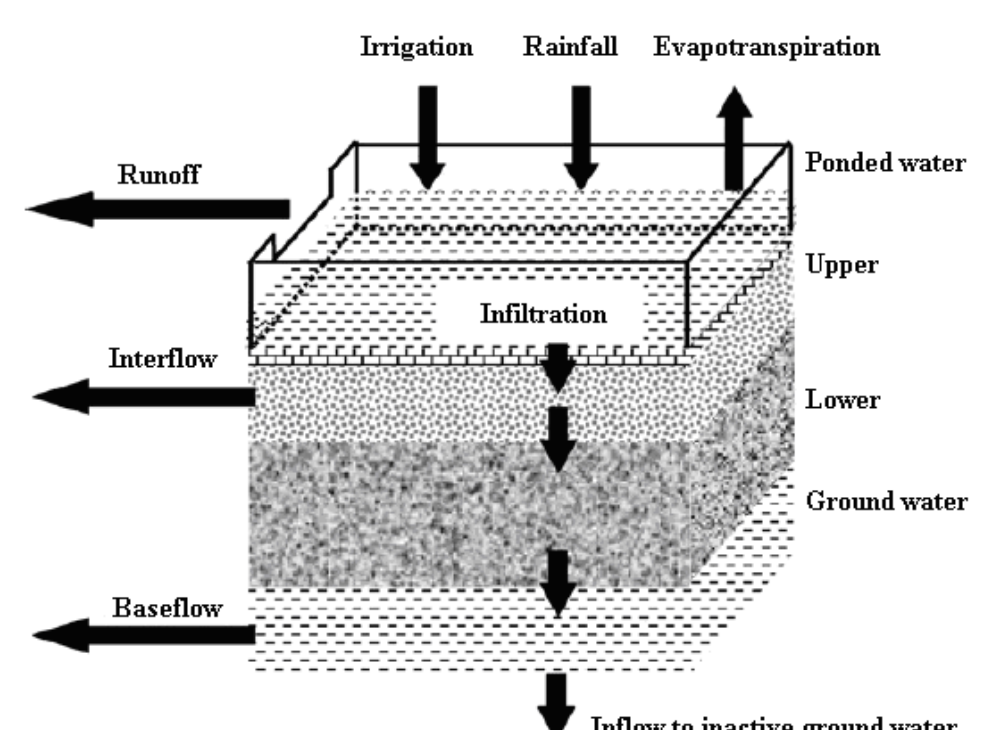
Figure 1. Schematic diagram of the water budget components in Hydrological Simulation Program-Fortran (HSPF)-Paddy model